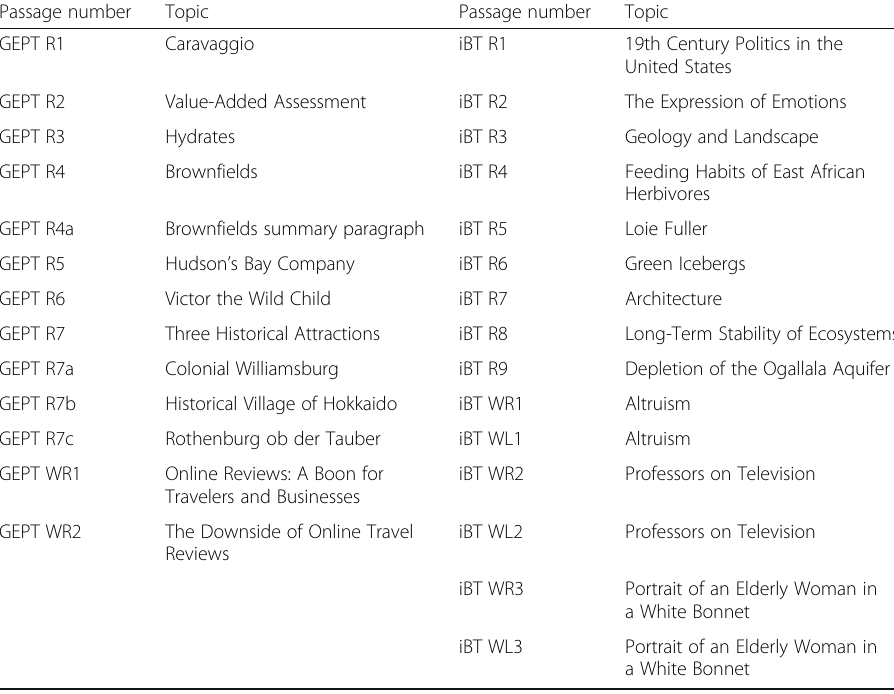
Table 1 Reading and listening passage identification key for GEPT-A and iBT Passage